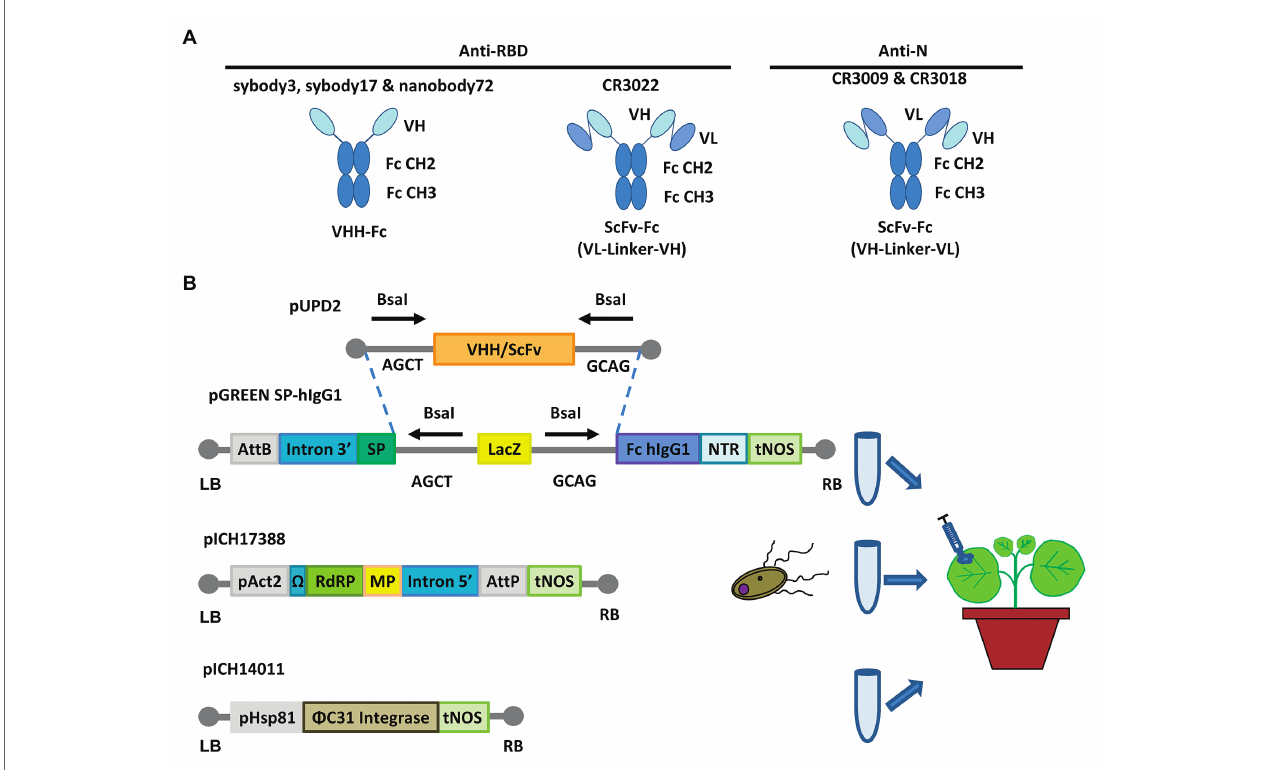
FIGURE 1 | Design for the expression of anti-SARS-CoV-2 recombinant antibodies. (A) Schematic representations of VHH-Fc and ScFv-Fc antibody versions. VHH, heavy chain only single domain antibody; ScFv, single chain variable fragment; Fc, human IgG1 C ɣ 2-C ɣ 3 domains. (B) Schematic representation of the cloning procedure for transient expression via MagnICON®. VHHs and ScFvs cloning into the pGreen SP-hIgG1 vector and coinfiltration together with the plasmids pICH17388 and pICH14011 for the in planta viral reconstruction (through Φ C31 mediated PB recombination) and antibody expression. AttB & AttP, site-specific recombination site; SP, signal peptide; NTR, nontranslated region; tNOS, terminator of nopaline synthase; pAct2, actine2 promoter of Arabidopsis thaliana ; RdRP, RNA-dependent RNA polymerase; MP, viral movement protein; pHsp81 promoter of the heat shock protein